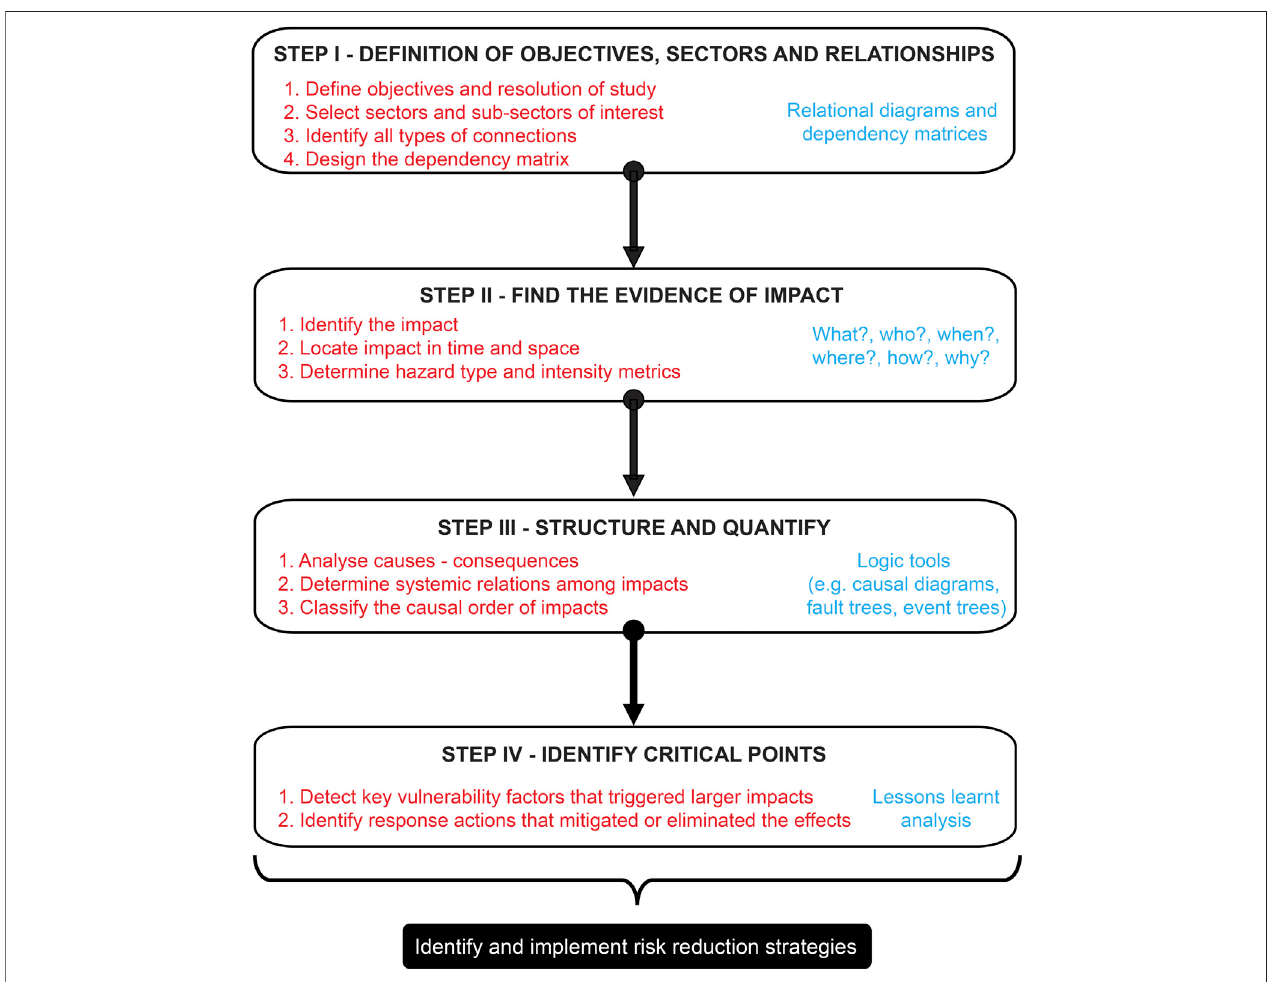
FIGURE 2 | Post-event impact assessment methodology proposed in this